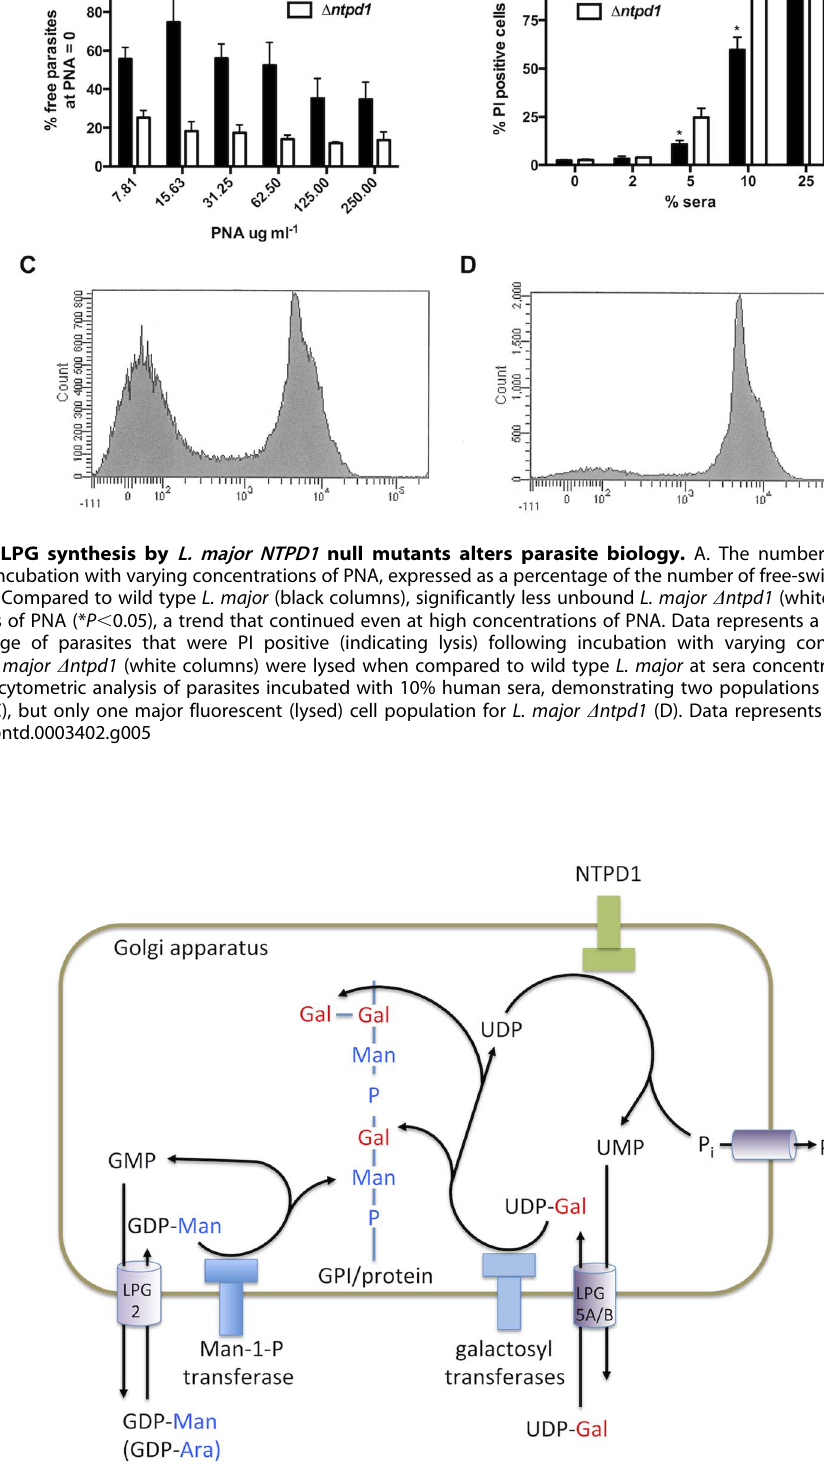
Fig. 6. Proposed model for the role of NTPD1 in Golgi nucleotide-sugar transport and LPG synthesis. UDP-galactose and GDP-mannose/ GDP-arabinose are transported into the Golgi via transporters LPG5A/LPG5B [37] and LPG2 [65] respectively. Galactose and mannose-phosphate are cleaved for use in phosphoglycan synthesis. Following cleavage, GMP is exchanged for GDP-mannose transport into the lumen. In the case of UDP, hydrolysis to UMP is catalyzed by NTPD1, allowing efficient ongoing transport of UDP-galactose into the Golgi lumen.